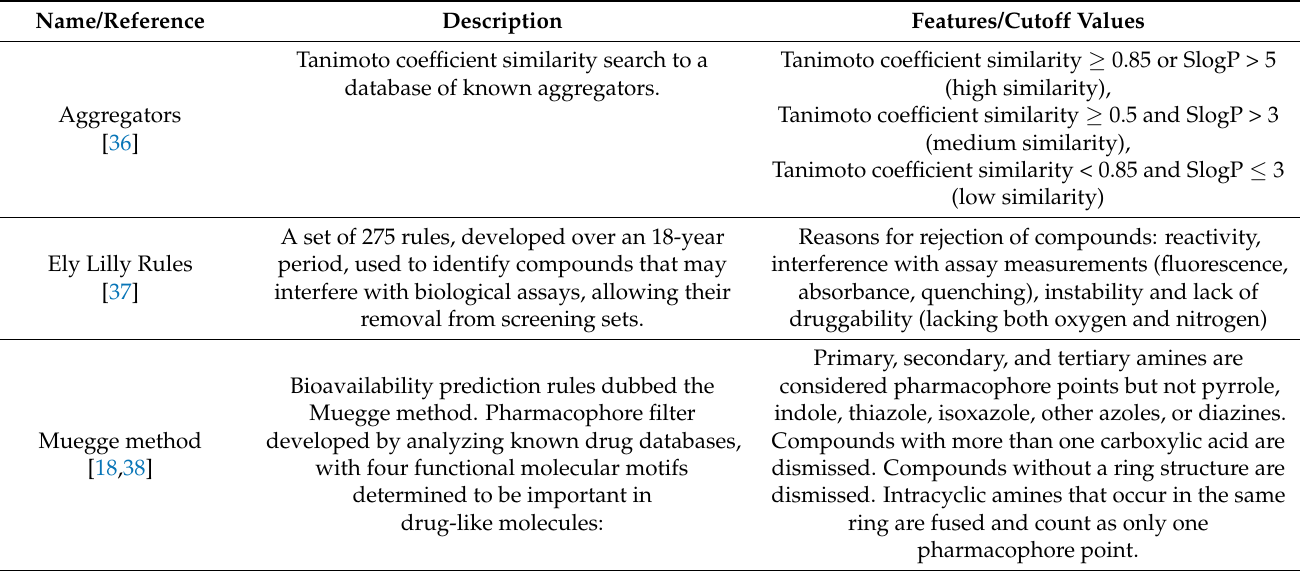
Table 1. The most common functional group filters described in the scientific literature presented in alphabetical